Question: What does this figure show? Answer in one sentence.
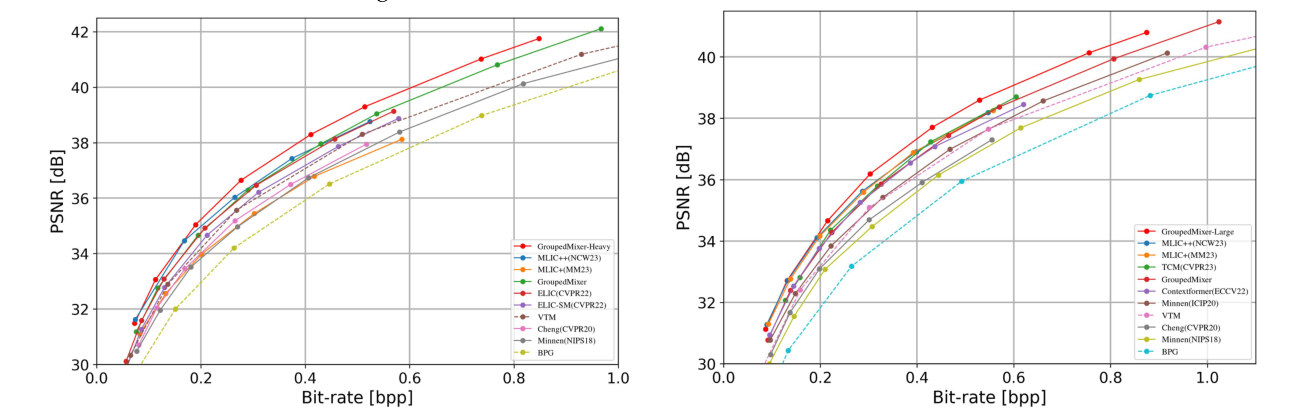
Answer: Performance evaluation on the CLIC’21 Test dataset.